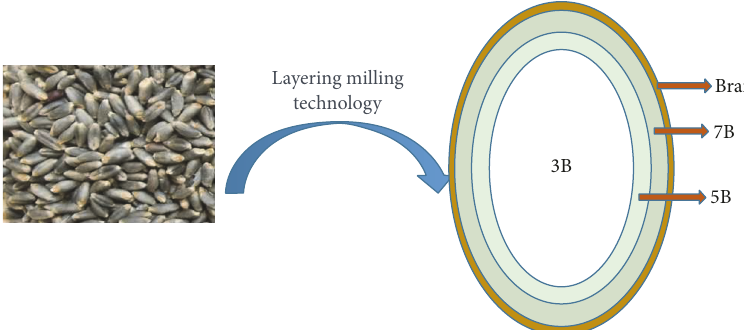
Figure 1: The model of layering milling technology on wheat